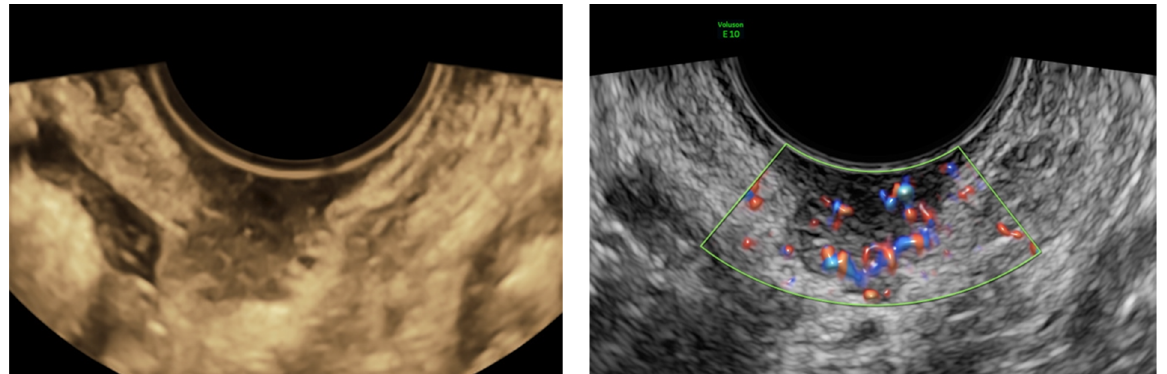
Figure 5. On the ( left ): 2D US images with VCI of a solid neoformation from the vaginal dome in a patient with a previous diagnosis of endometrial cancer. On the ( right ): Doppler US image of the same neoformation highlighting the vascularization in the lesion.